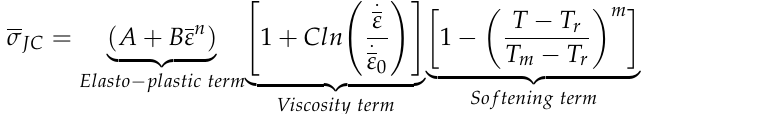
Figure 1. While conduction is taken as the mode of heat transfer at the tool-workpiece